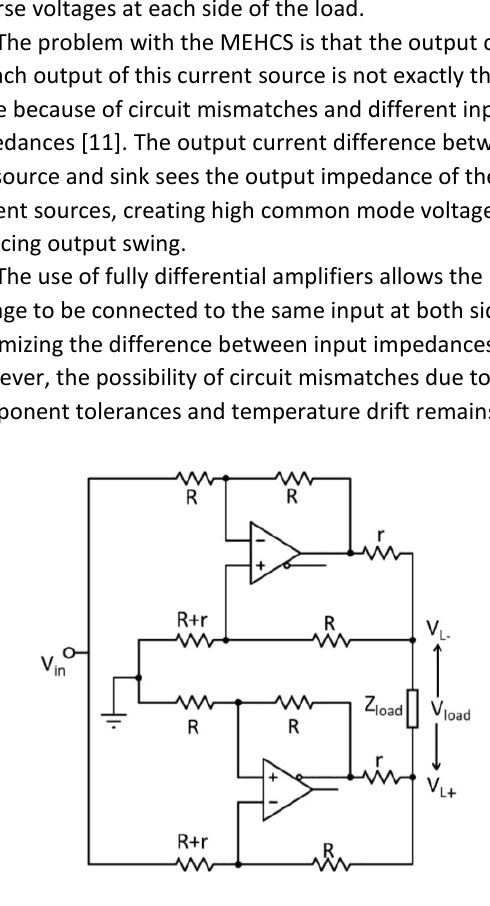
Fig.6: Mirrored Enhanced Howland Current Source with differential amplifiers (MEHCS-